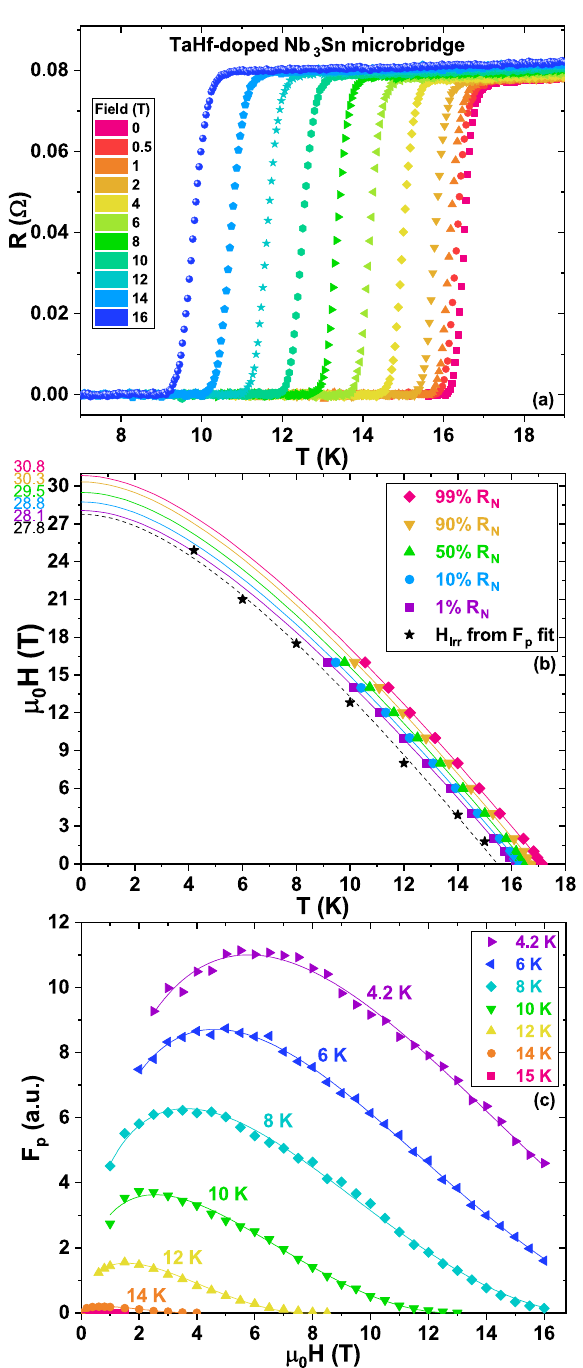
Figure 2. Transport characterizations of Ta-Hf-doped Nb 3 Sn microbridge. Superconducting characterization of a Ta-Hf doped Nb 3 Sn sample. ( a ) Resistive transitions at field up to 16 T. ( b ) H c2 ( H Irr ) versus temperature determined by different resistive criteria (see text) from ( a ) and from the fits in ( c ). ( c ) F p versus field data at different temperatures with fitting curves (see